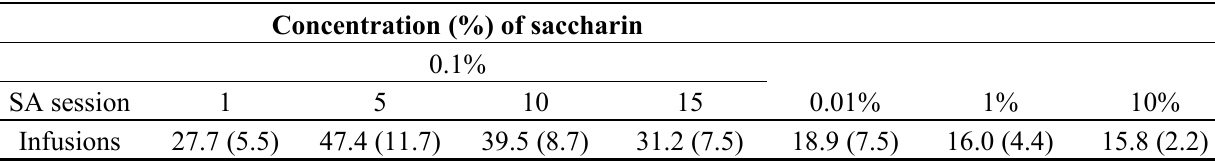
Table 1. Mean (SEM) infusions obtained on a fixed ratio one schedule of reinforcement by rats that self-administered infusions of 0.1% (self-administration (SA) Sessions 1–15), 0.01%, 1% and 10%